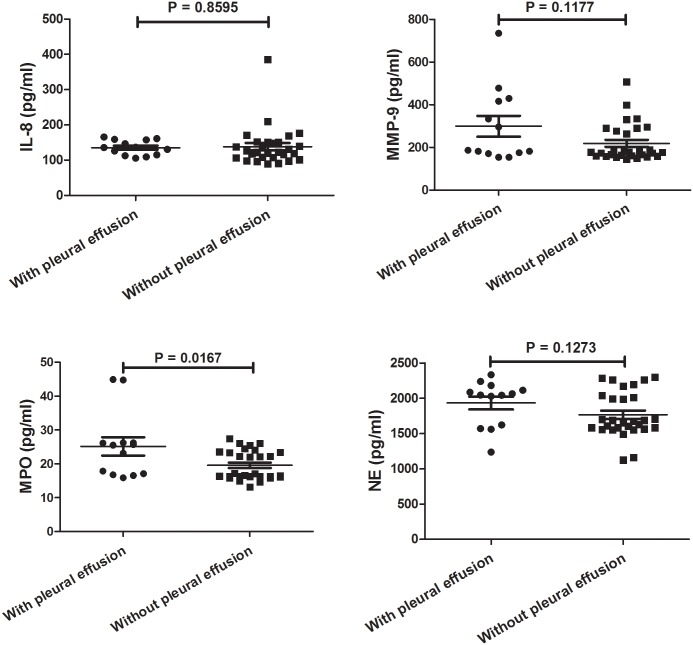
Comparison of IL-8, MPO, MMP-9, and NE in BALF between Patients with and without Pleural Effusion.The values in the graphs represent the mean ± SD. The P values were calculated using Student’s t test while Mann-Whitney U-test was used for comparison of MMP-9 and MPO between two groups. IL: interleukin-8; MPO: myeloperoxidase; MMP-9: matrix metalloproteinase 9; NE: neutrophil elastase.